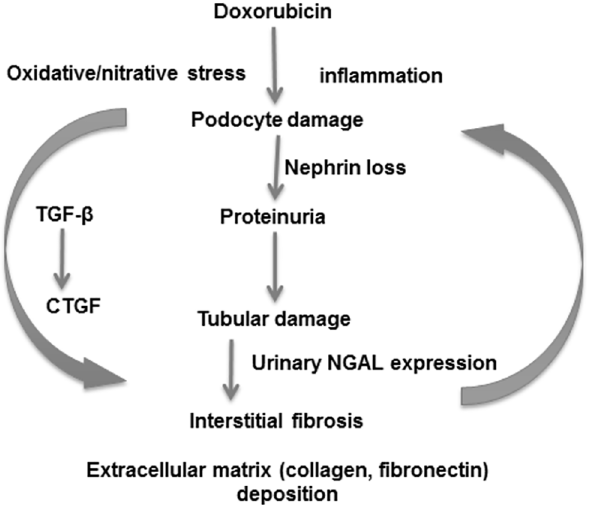
Fig 6. Suggested mechanisms of doxorubicin induced nephropathy. A single administration of doxorubicin induced podocyte damage demonstrated by loss of nephrin and leading to proteinuria. Proteinuria damages tubules as demonstrated by increased urinary NGAL excretion. Tubular damage leads to interstitial inflammation and fibrosis with collagen and fibronectin deposition. Inflammation is accompanied by oxidative/nitrative damage triggering further immune activation. Reverse arrows symbolize main elements of the vicious circle. Sustained injury activates the TGF- β 1 and CTGF profibrotic axis. Sustained